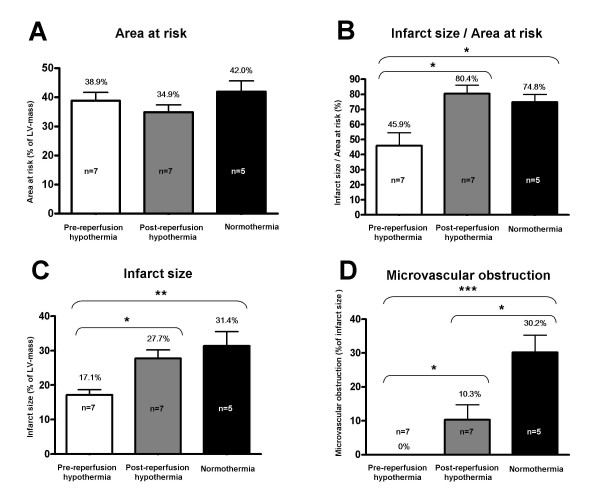
(a) Size of area at risk (AAR) by SPECT. There was no difference in AAR between the different groups. (b) Infarct size (IS) measured by ex-vivo MRI as a percentage of area at risk (AAR) by SPECT in the two groups. Pre-reperfusion hypothermia causes a 43% relative reduction in infarct size compared to post-reperfusion hypothermia and by 39% compared to normothermia. (c) Infarct size (IS) measured by ex vivo MRI, expressed as a percentage of the left ventricular mass. (d) Microvascular obstruction measured by ex vivo MRI, expressed as a percentage of the infarct size. Pre-reperfusion hypothermia totally abolished microvascular obstruction. Post-reperfusion hypothermia significantly decreased the extent of micovascular obstruction compared to normothermia. (* = p < 0.05, ** = p < 0.01, *** = p < 0.001). Data are expressed as mean ± SEM.